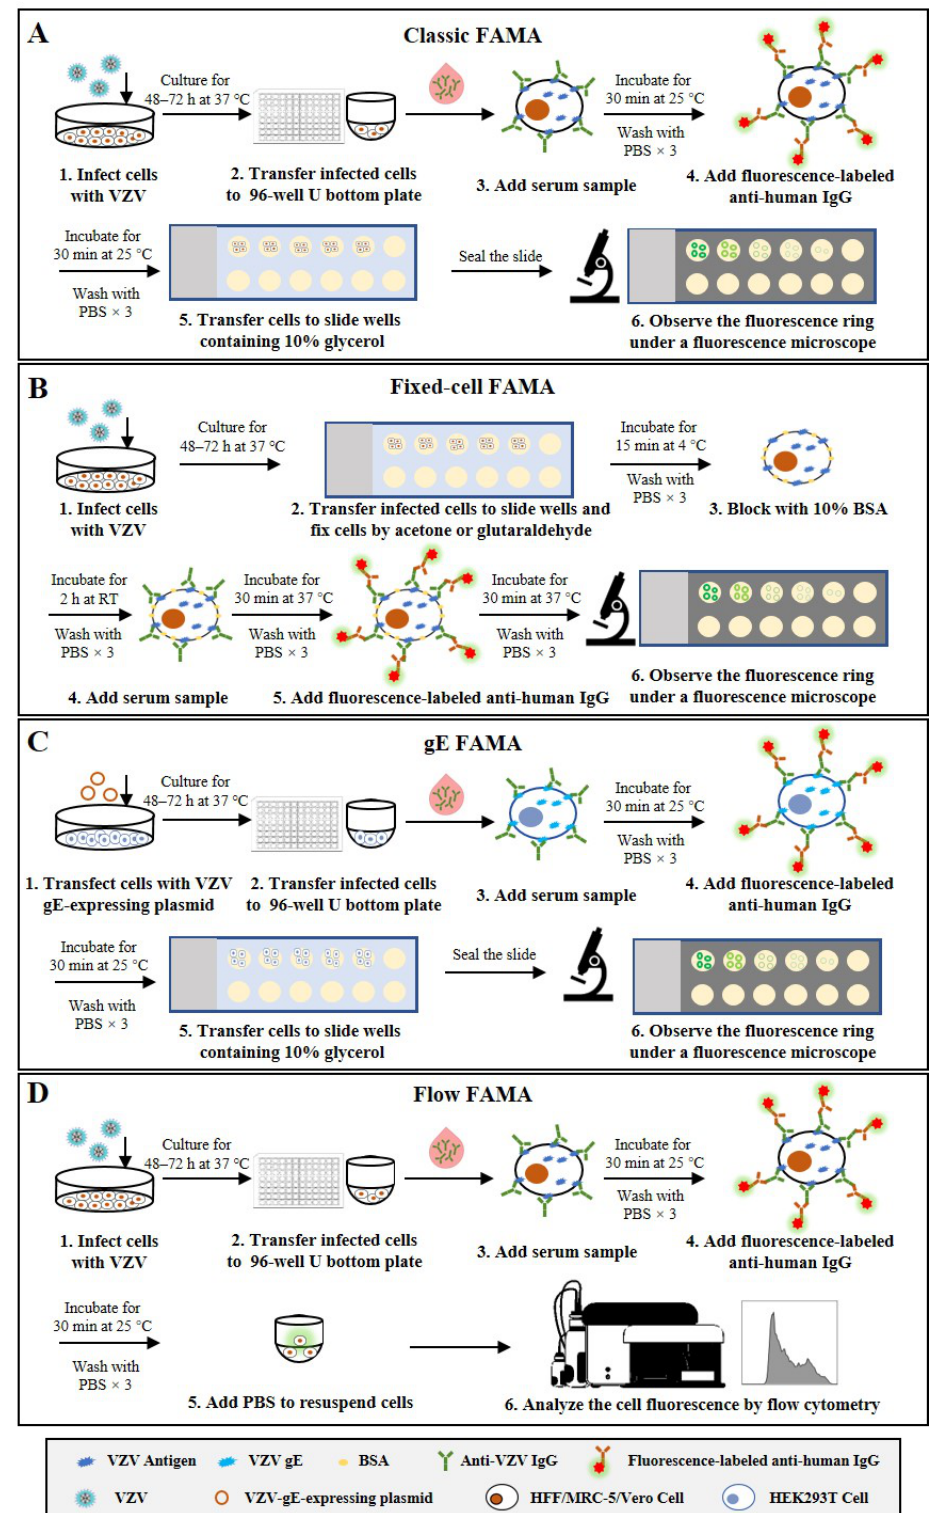
Figure 1. Schematic representation of the basic protocols for four types of FAMA that detect anti-VZV antibodies. ( A ) Classic FAMA using live VZV-infected cells to capture anti-VZV antibodies. ( B ) Fixed-cell FAMA using chemically fixed VZV-infected cells to capture anti-VZV antibodies. ( C ) gE-FAMA using VZV-gE-expressing live cells to capture anti-VZV-gE antibodies. ( D ) Flow FAMA using flow cytometry to analyze the fluorescence-labeled VZV-infected